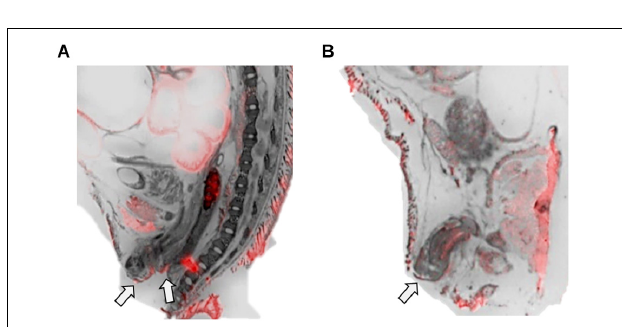
FIGURE 4 | OXTR ligand binding in the anogenital area of neonatal prairie voles. Pseudo-color composites (OXTR in red, cresyl violet counterstain in gray) of (A) female neonatal prairie vole with 0 nM OXT competition and (B) male neonatal prairie vole with 0 nM OXT competition White arrows indicate areas where quantifications were measured. Females did not display robust OXTR signal visible to the naked eye in the vaginal canal, only on external anogenital tissue. Males, however, displayed OXTR signal on internal and external genital tissue. Quantifications for this study only measured external anogenital tissue.